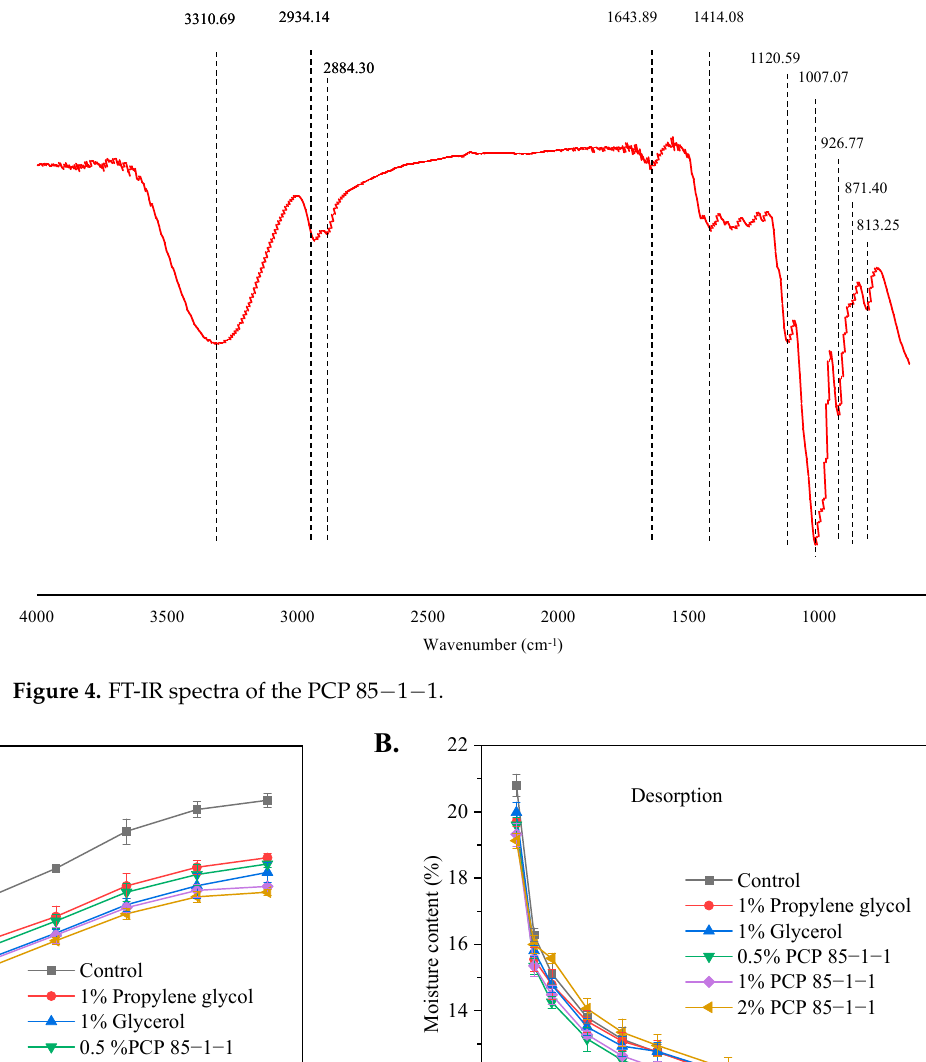
Figure 5. ( A ) Moisture adsorption of tobacco shreds with PCP 85 − 1 − 1. ( B ) Moisture desorption characteristics of tobacco shreds with PCP 85 − 1 −